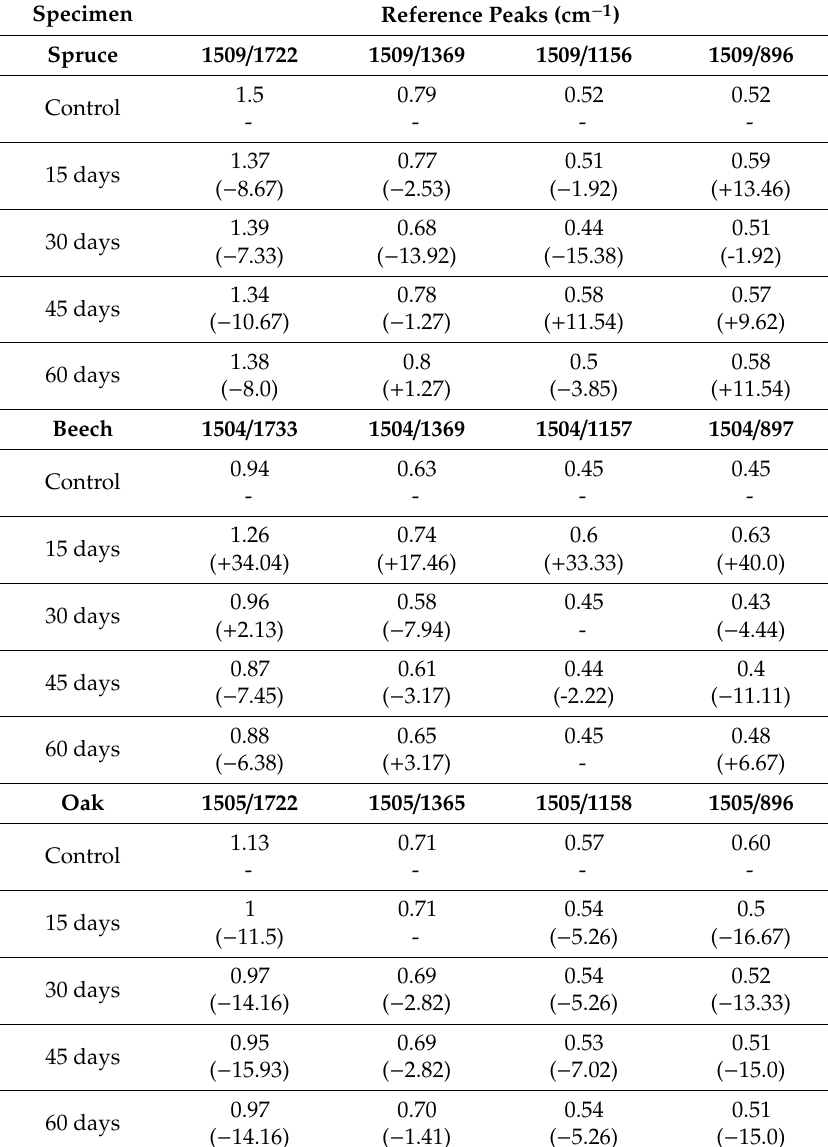
Table 4. Ratio of the intensity of lignin associated bands with carbohydrate bands for wood blocks degraded by P. ostreatus